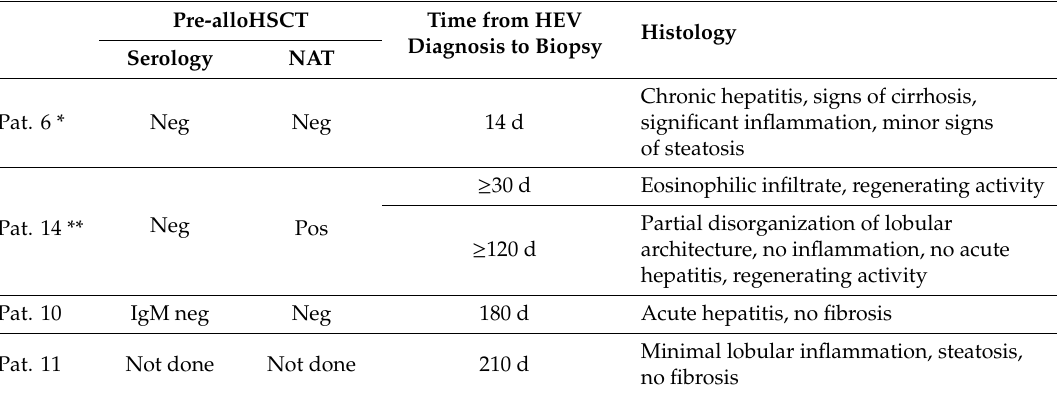
Table 2. Liver histology in four patients with